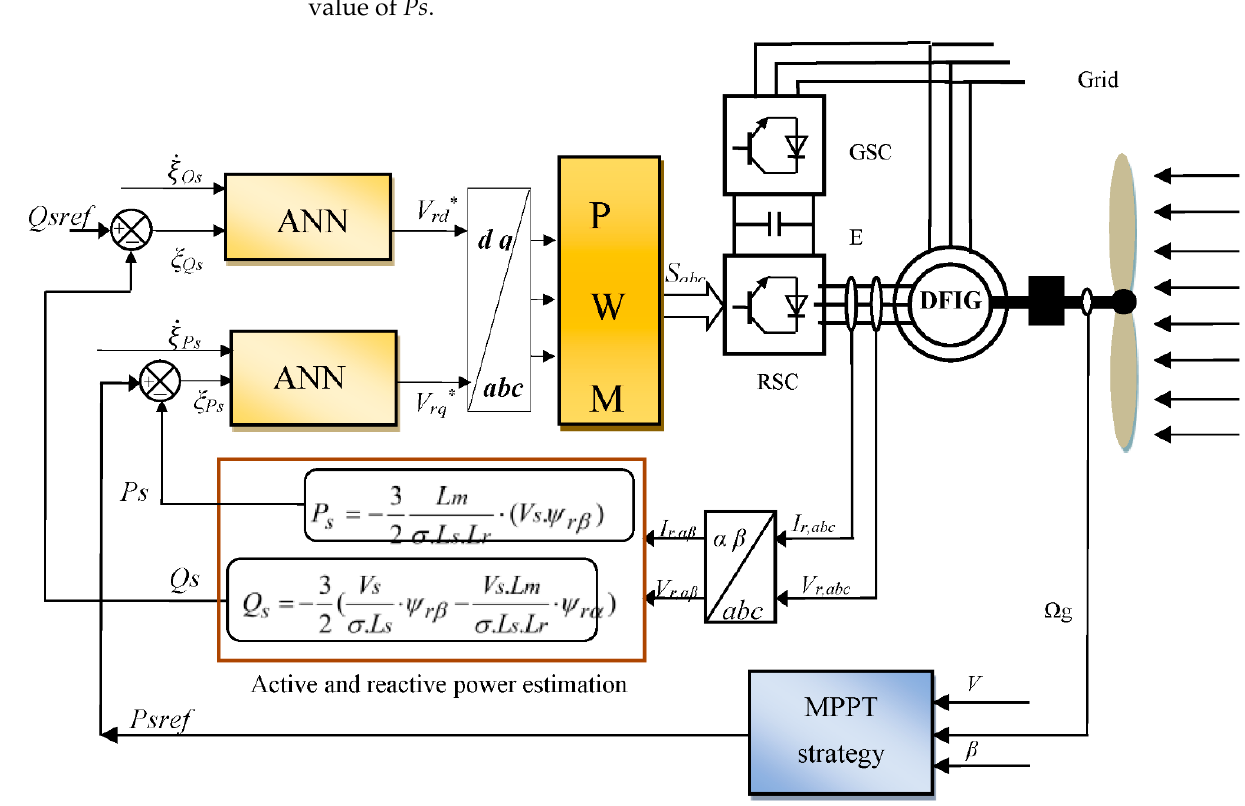
Figure 7. Block diagram of the designed intelligent DPC method.